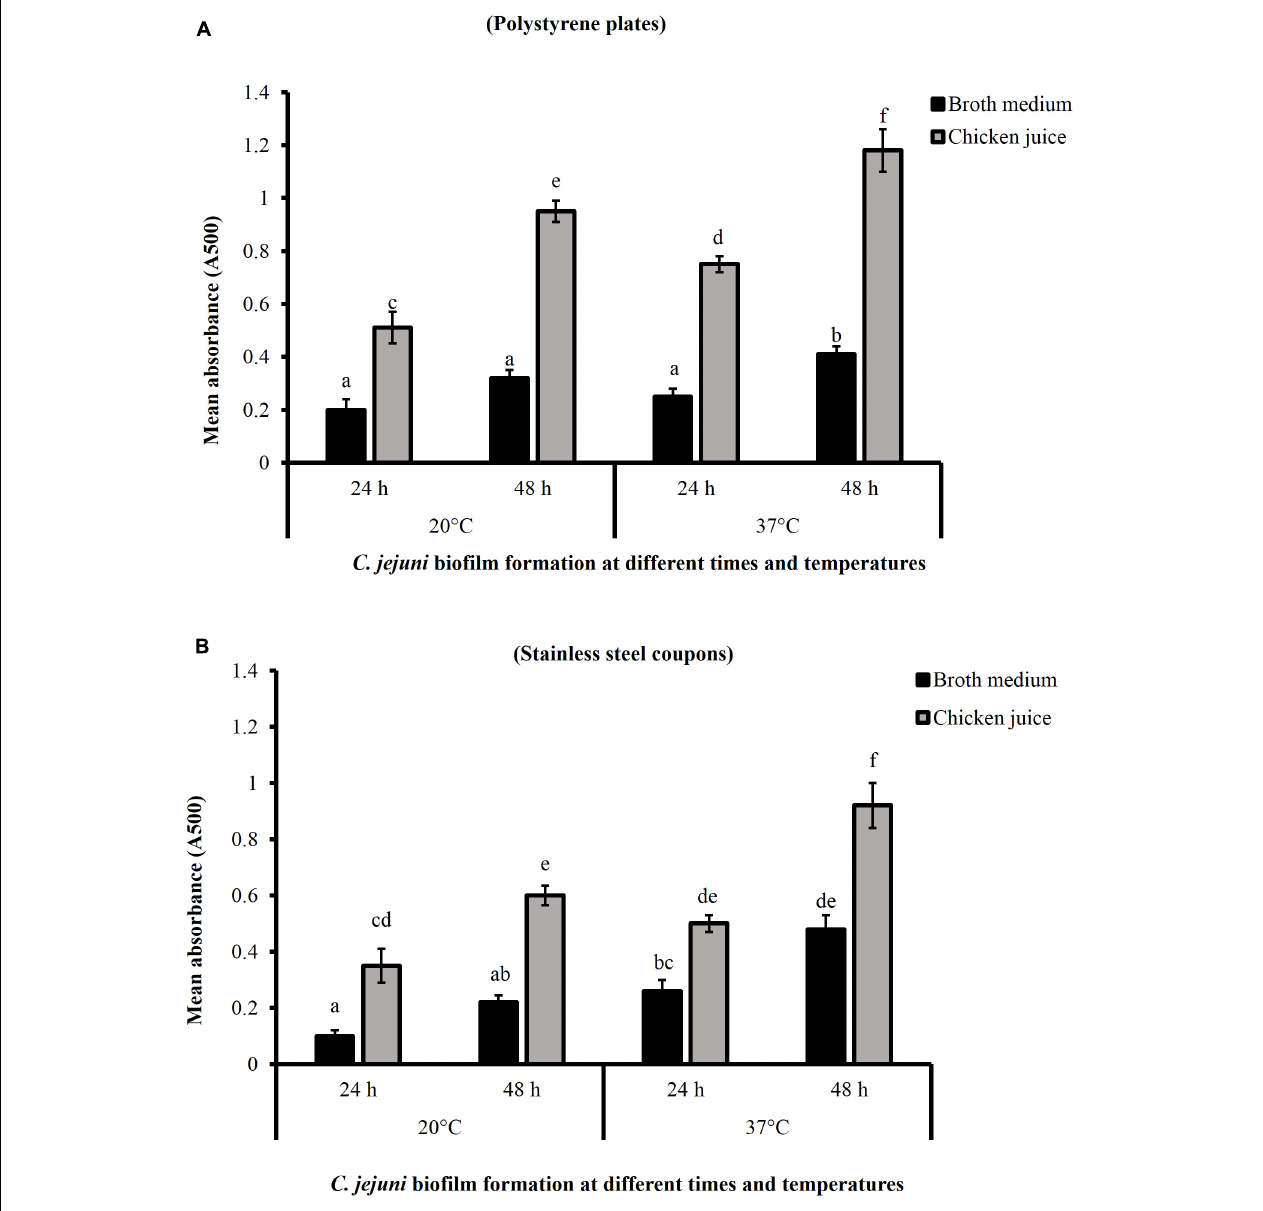
FIGURE 1 | Campylobacter jejuni biofilm formation on polystyrene plates (A) and stainless-steel coupons (B) at 20 and 37 ◦ C. Error bars represent SEM ( n = 6). C. jejuni ( ∼ 6.0 Log CFU/mL) in the presence or absence of 5% chicken meat juice was incubated to form biofilm. The biofilm formation was determined by TTC staining at 24 h interval. Different letters indicate the statistical difference across time or temperatures ( P <